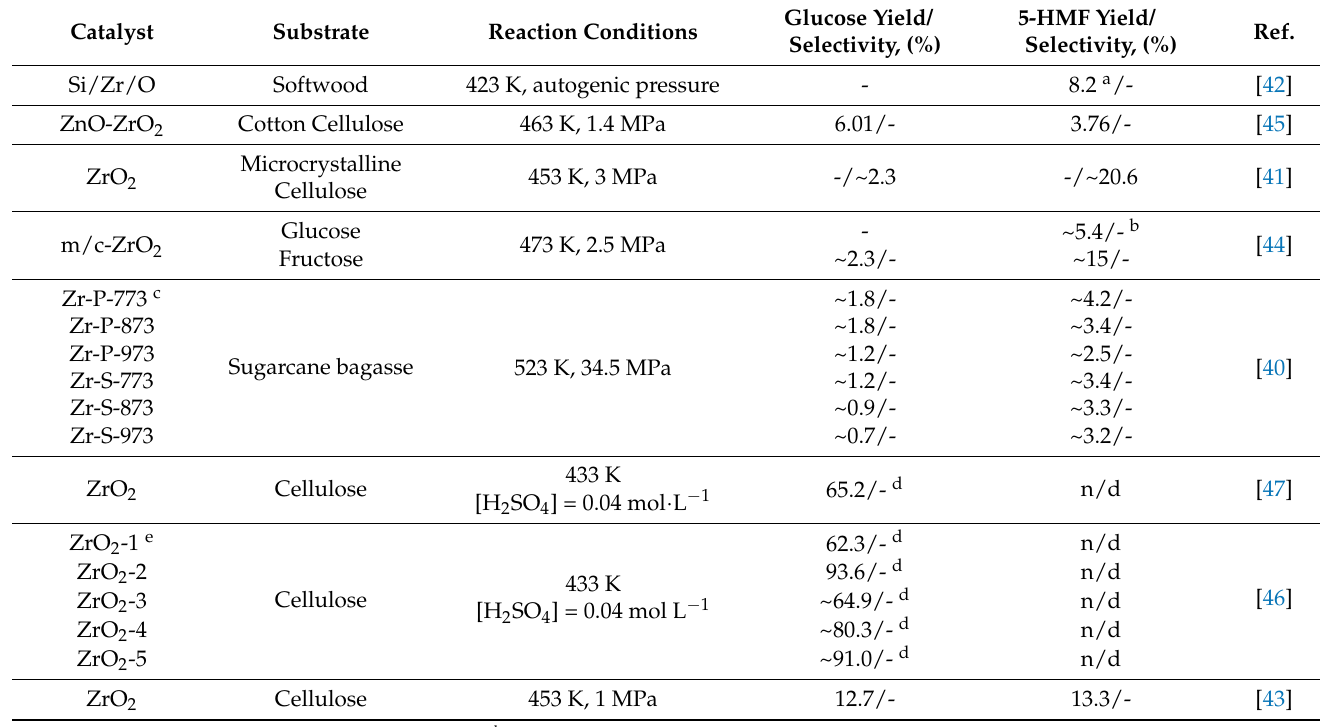
Table 1. Activity of ZrO 2 catalysts in hydrolysis-dehydration of plant biomass and cellulose. Catalyst